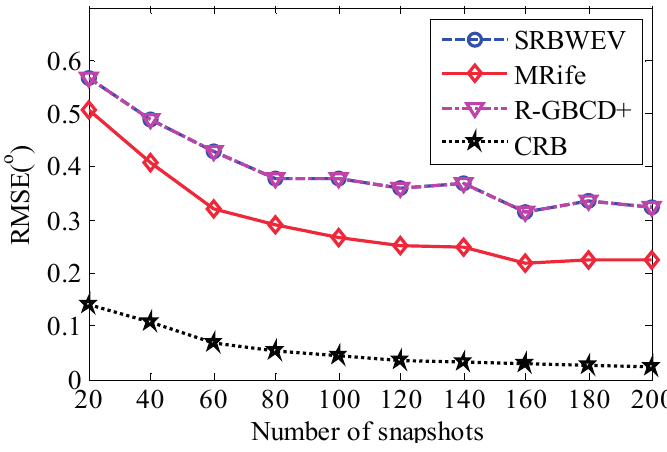
Figure 6. RMSE of DOA estimation versus number of